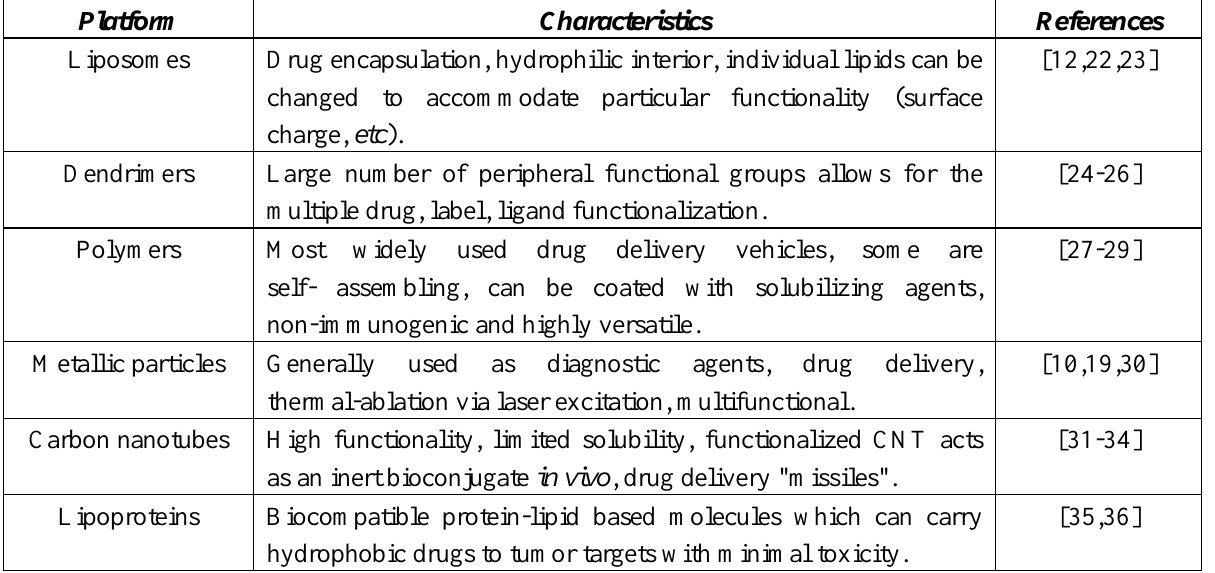
Table 1. Examples of different nanomaterial platforms available for use in drug delivery systems